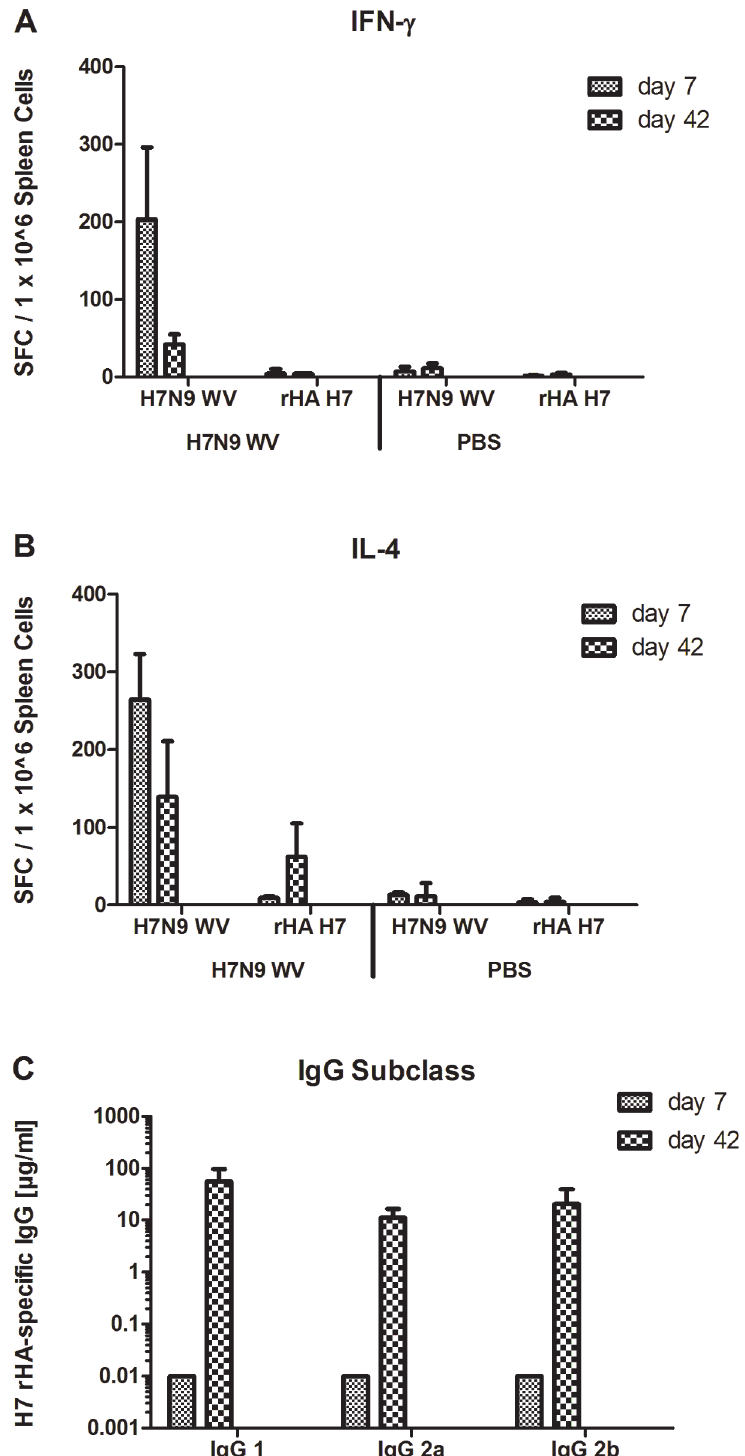
Fig 3. Th-1 and Th-2 cytokine and IgG subclass responses in mice immunized with pandemic H7N9. DBA/2J mice were immunized with whole-virus (WV) H7N9 vaccine or buffer as control on days 0 and 21. Spleen cells were collected 7 days after the first, or 21 days after the booster immunization (i.e. 42 days after the first), and stimulated with whole-virus (WV) H7N9 vaccine or recombinant H7 HA (rHA) for the determination of cells responding to the antigens by secretion of either IFN- γ (A) or IL-4 (B) using